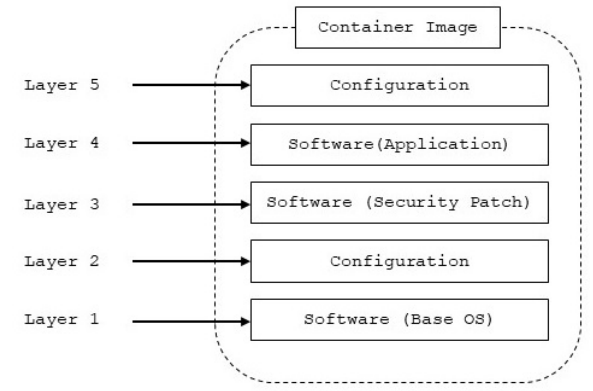
Figure 4. Container Image